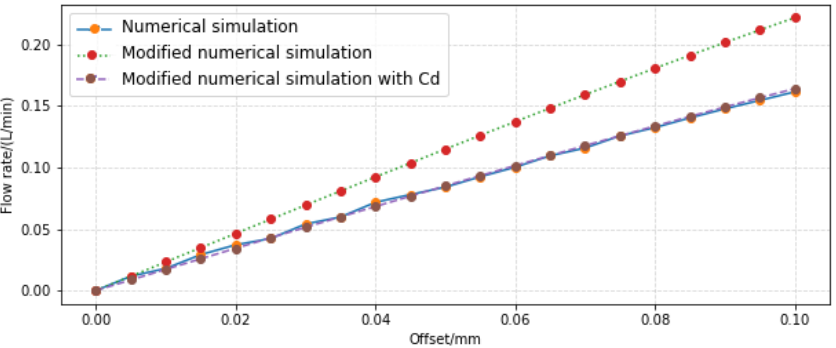
Figure 15. Variation curve of load flow with offset.